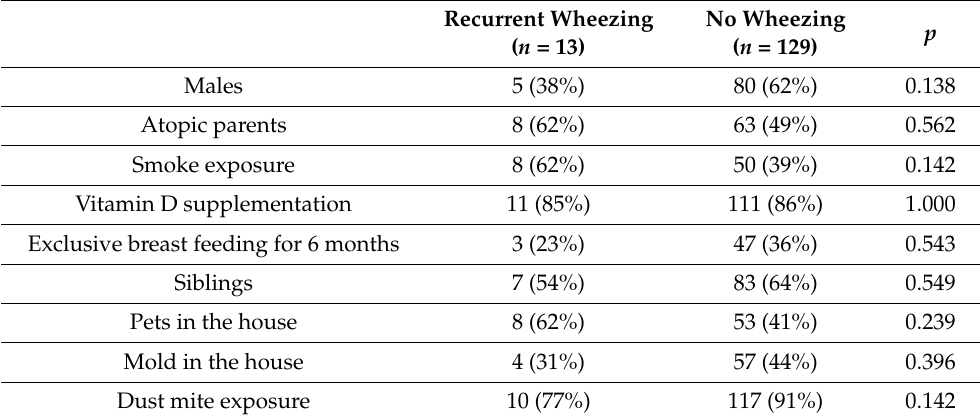
Table 2. Risk factors distribution in children according to the development of recurrent wheezing in the no-bronchiolitis group.